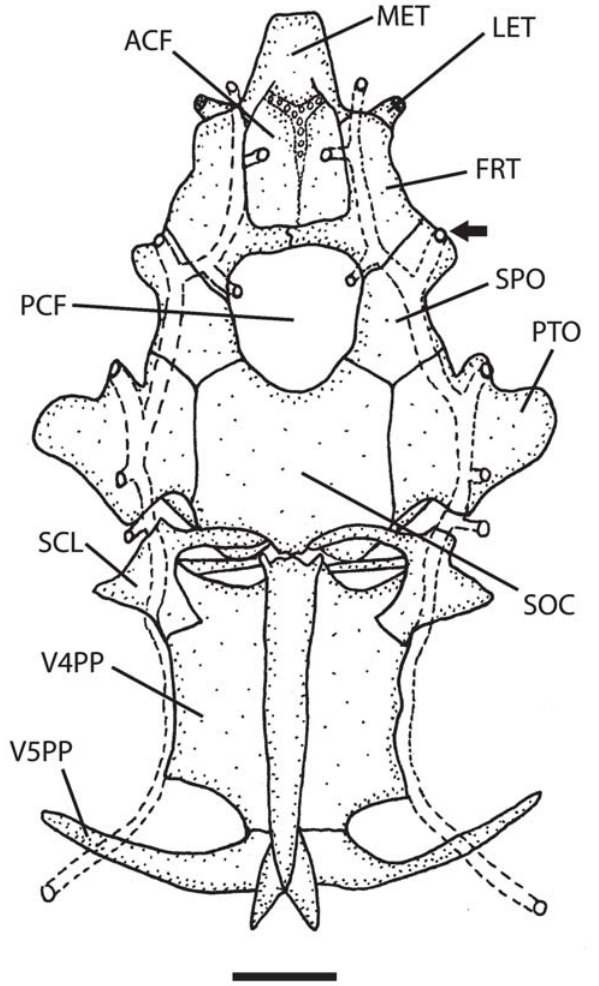
Fig. 3. Dorsal view of the neurocranium and Weberian com- plex of Pseudobunocephalus lundbergi , ANSP 172505. Ar- row indicates the exit of the infraorbital canal from the sphe- notic. Scale bar equals 1